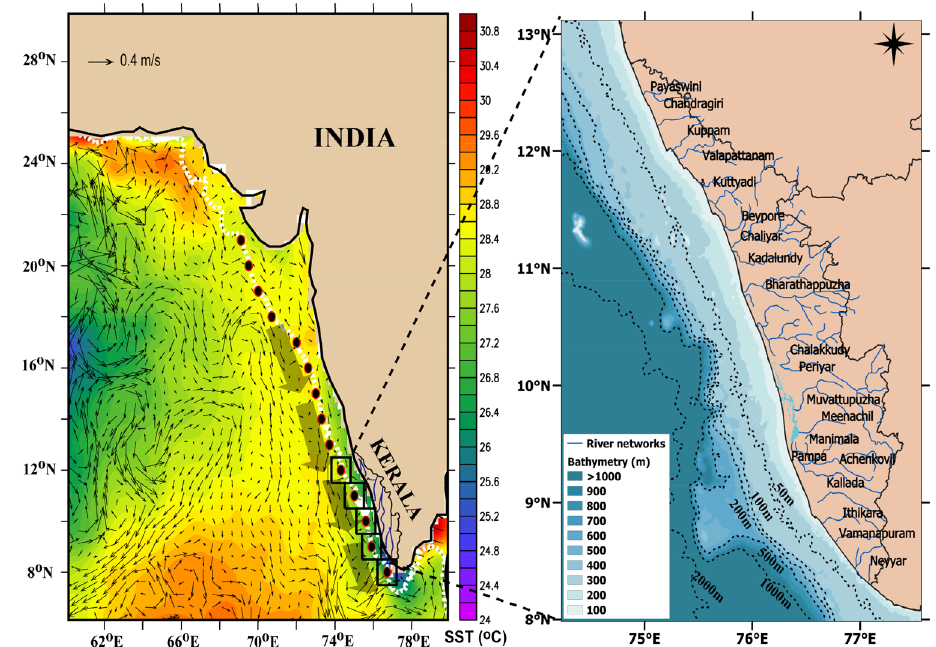
Figure 2. Location map of the eastern Arabian Sea showing the study area (left panel). Red circles filled with black are the station locations from where in situ water column data were collected during 3rd to 28th August 2017. The white dashed line represents the 200 m depth contour. Shading is the sea surface temperature (SST, °C) and overlaid vectors represent the geostrophic current both for August 2017 obtained from NOAA and CMEMS respectively. The black squares are the boxes centered at in situ stations from 8° to 12° N used for the calculation of time series of various parameters. The wide grey-shaded arrows along the EAS represent the West India Coastal Current (WICC). The river network map of Kerala along with bathymetry is also given (right Panel). Figure was created using using Ferret and QGIS software. See text for